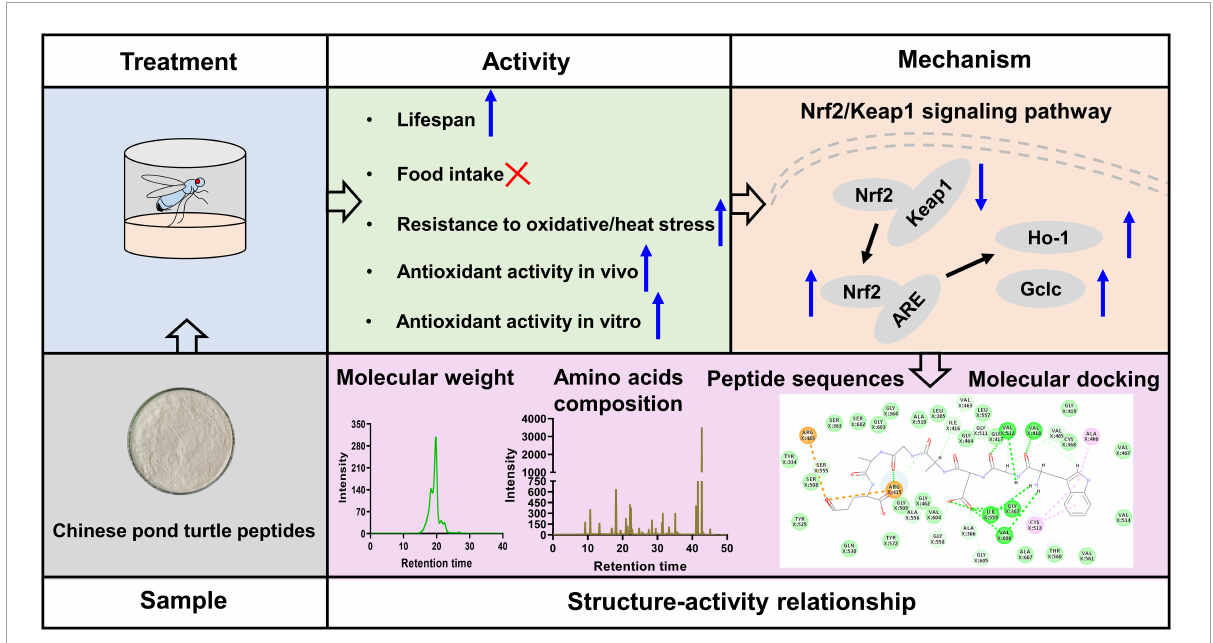
FIGURE7 Antioxidant and antiaging effects of Chinese pond turtle peptide (CPTP) via the Nrf2/Keap1 signaling pathway in mice.